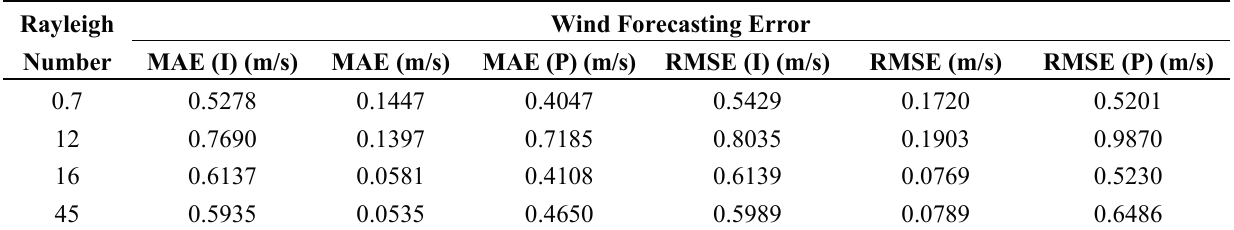
Table 5. MAE and RMSE results of wind speed prediction in February 2014.